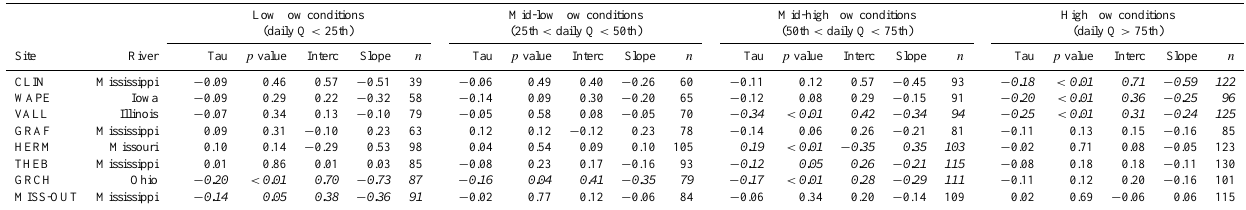
Table 5. Kendall’s tau and robust line results of nitrate anomaly and Qratio relationships, by contemporaneous flow class. Statistically significant values ( p < = 0 . 05) are italicized [daily Q, daily streamflow; Interc, intercept; n , number of